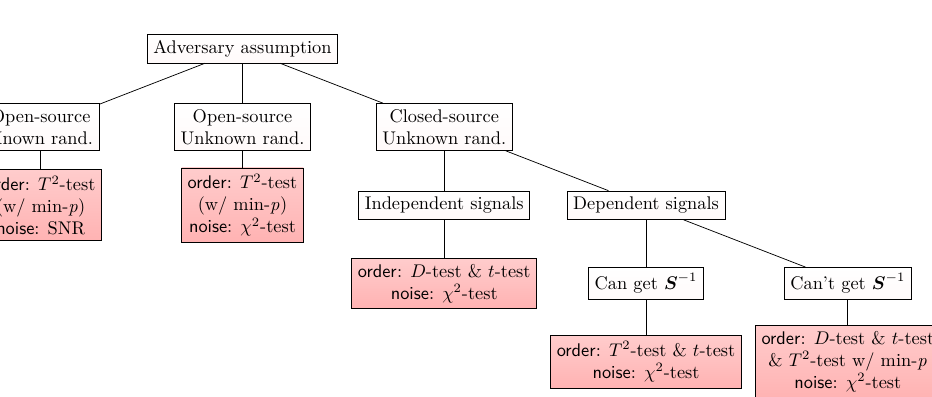
Figure 12: Proposed security assessment